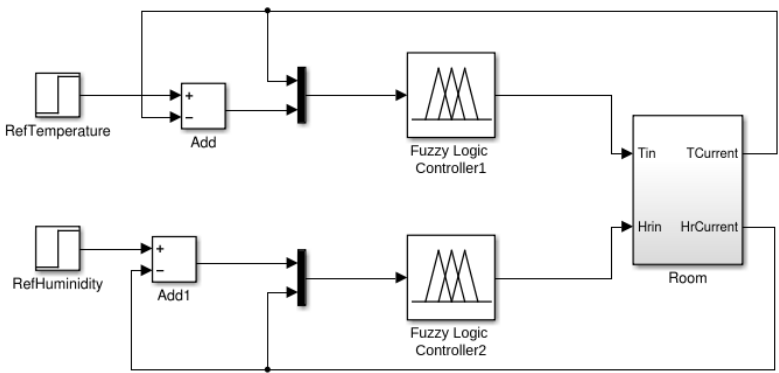
Figure 2. Block diagram of temperature and humidity fuzzy control for a simple room’s systems.